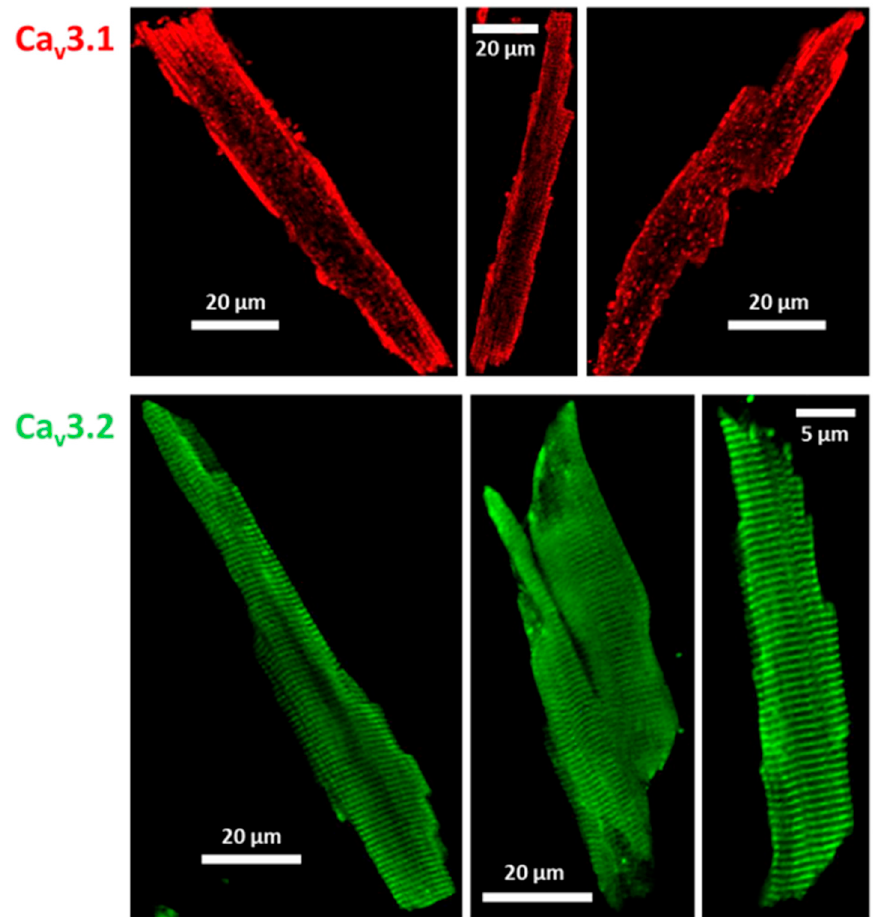
Figure 2. Immunostaining of T-type Ca channels in ventricular cardiomyocytes isolated from adult wt mice. Cav3.1 ( top ) channel expression and localization was detected using a selective anti-Cav3.1 antibody (anti-CACNA1G, #ACC-021, source: rabbit, Alomone Labs, 1:500). Cav3.2 ( bottom ) was detected with the selective anti-Cav3.2 antibodies (anti-CACNA1H, #ACC-025, source: rabbit, Alomone Labs, 1:1000; left and right cell; or anti-Cav3.2 polyclonal, #PA5-106771, source: rabbit, Invitrogen, 1:200; middle cell). Secondary antibody: Alexa Fluor 488, #A11008, goat anti-rabbit, Invitrogen, 1:500.